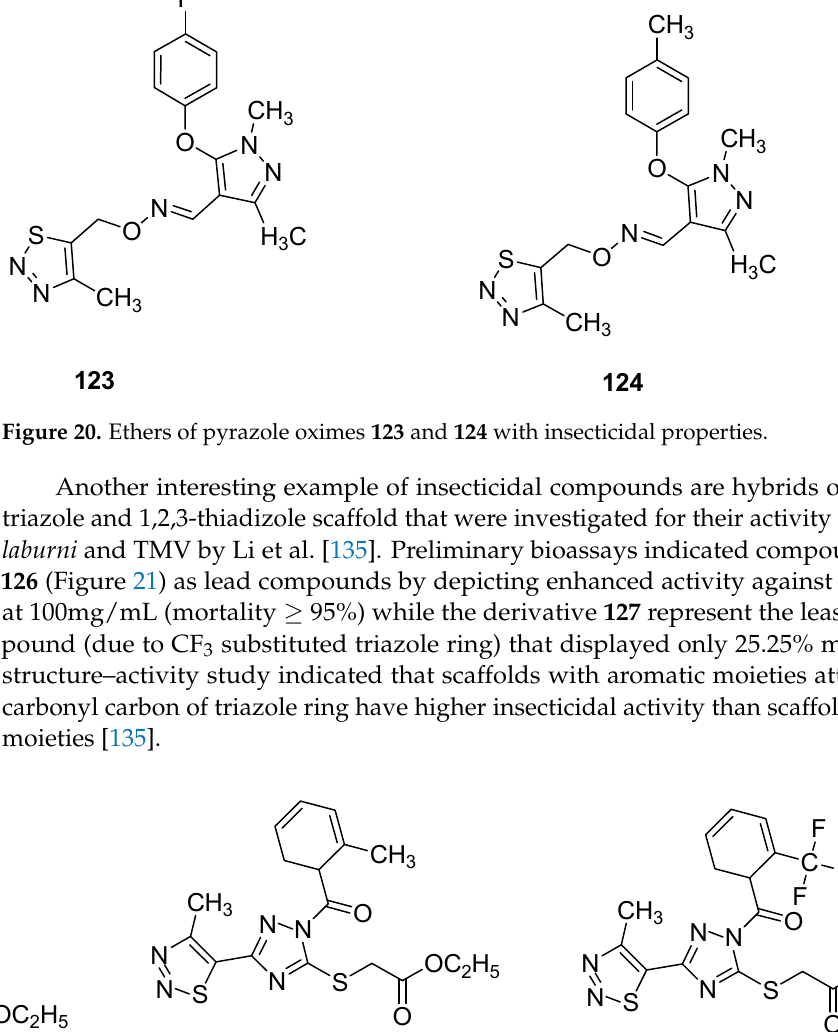
Cl 122 Figure 19. Insecticide E β f 1,2,3-thiadiazole carboxamides 120–112 . Pyrazole oxime derivatives, as a new Fenpyroximate analogue bearing a thiadiazole moiety, were synthesized by Dai et al. and then their insecticidal, acaricidal and cytotoxic